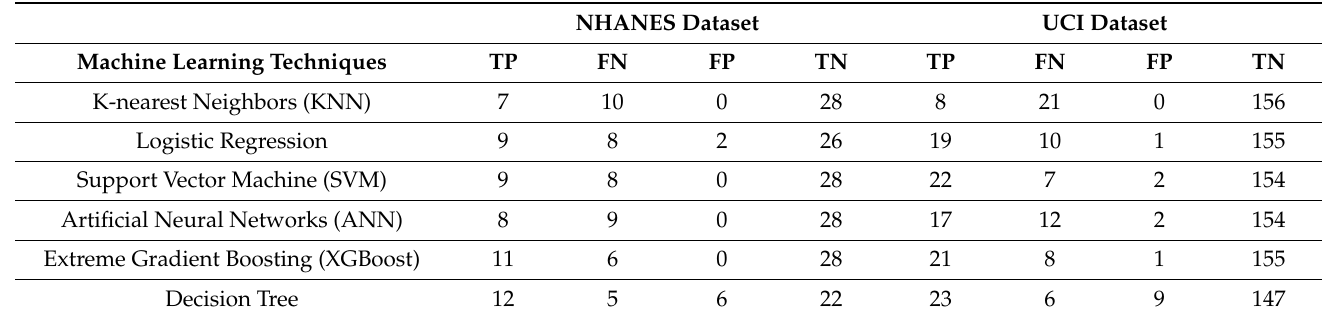
Figure 5. ROC curve and AUC obtained by six machine learning algorithms employing the NHANES ( left ) and UCI ( right ) datasets. Table 4. Numbers of TP, FP, TN, and FN cases of the six machine learning algorithms on the two datasets (the figures of the confusion matrices of these algorithms are shown in the Supplementary Materials, (Figure S1) NHANES Dataset, (Figure S2) UCI dataset).